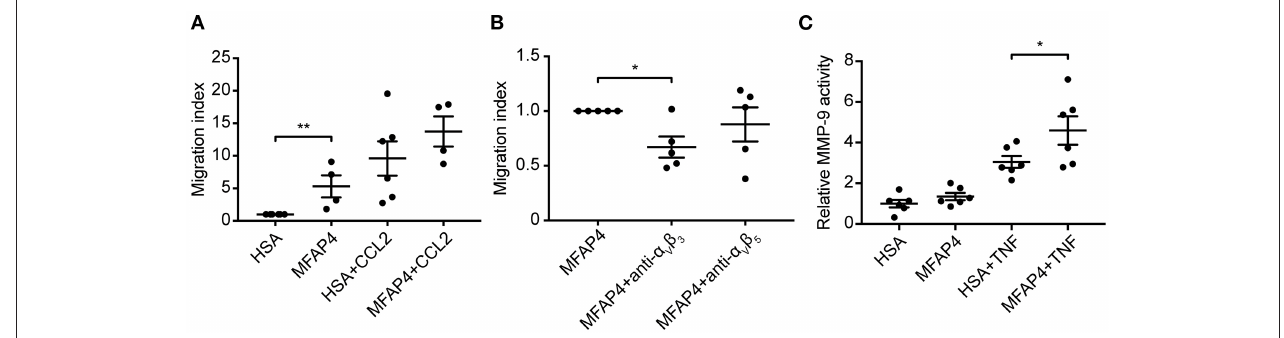
FIGURE 6 | MFAP4 induces monocyte migration and MMP-9 activity in macrophage-like cells in vitro . (A) MFAP4 acts as a haptoattractant for human blood monocytes. (B) MFAP4-dependent monocyte directional migration can be inhibited by anti-integrin α V β 3 antibody. (C) MFAP4 stimulation potentiates TNF-induced